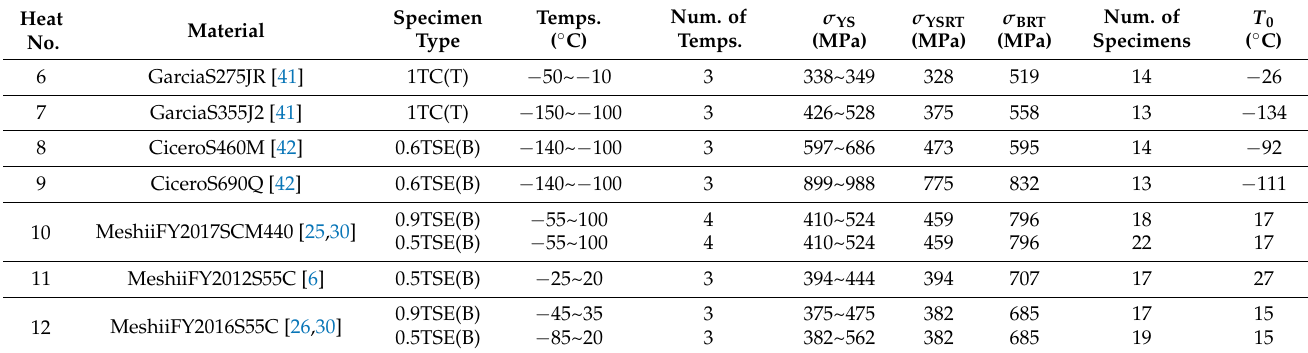
Table 4. K J c data used to construct the proposed tensile property-based MC: non-RPV steels. Heat